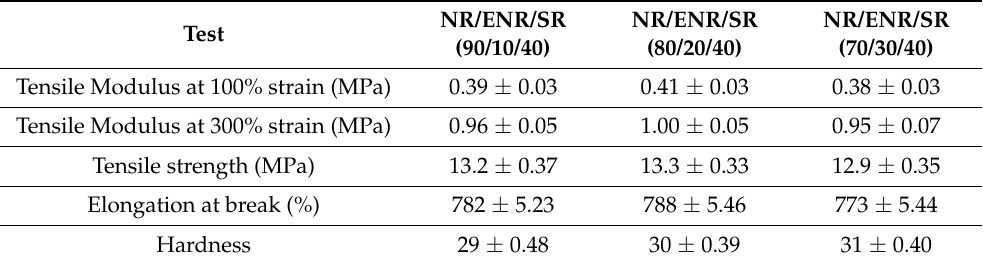
Table 2. Tensile properties of NR/ENR/SR rubber composites